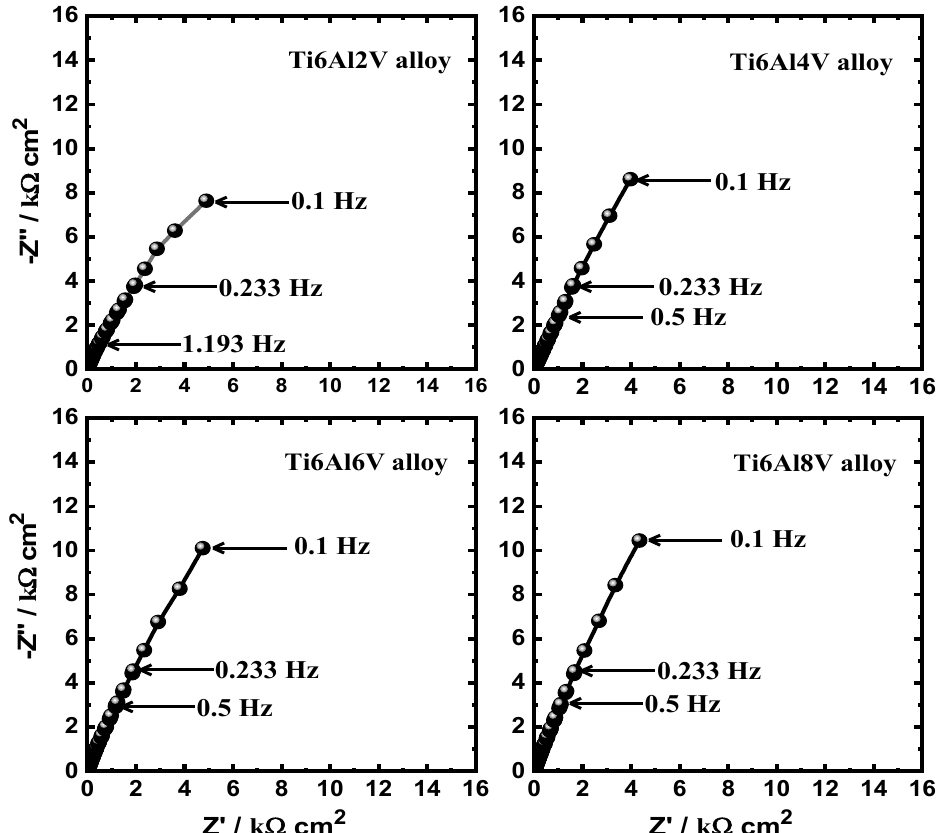
Figure 1. Nyquist plots measured for the di ff erent TiAlV alloys after their immersion in NaCl solutions for 1